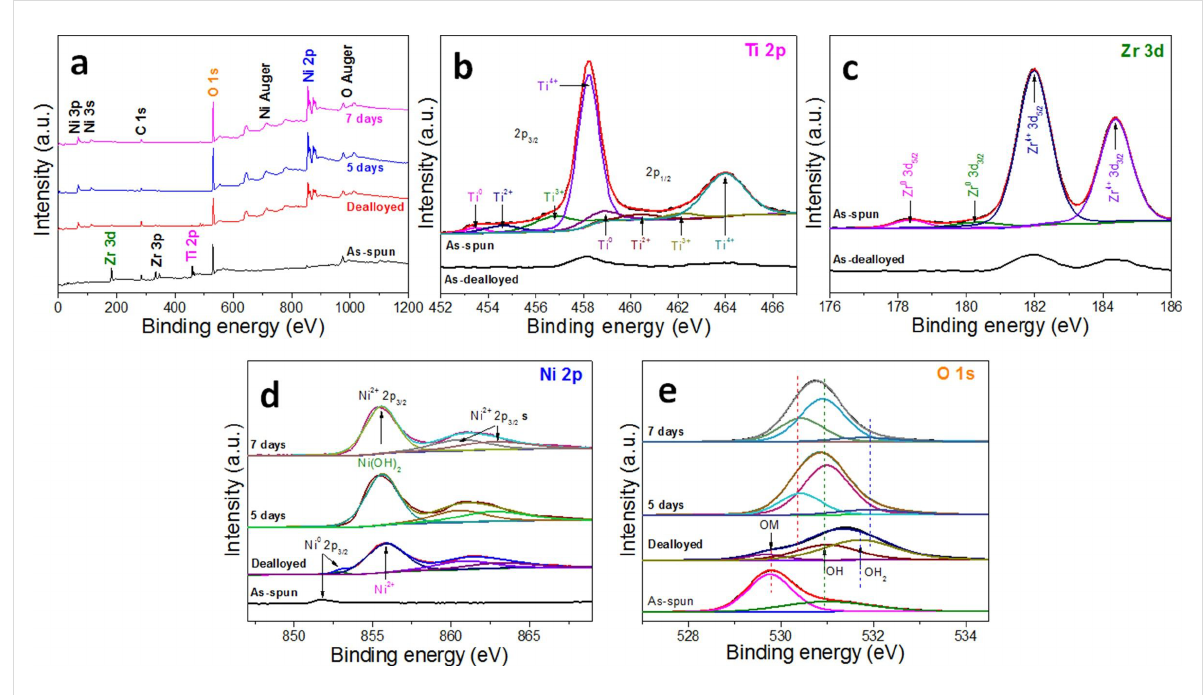
Figure 4: XPS spectra of the elements of the as-spun ribbon, as-dealloyed ribbon and as-synthesized electrode: (a) survey spectrum, (b) Ti 2p, (c) Zr 3d, (d) Ni 2p and (e) O 1s.